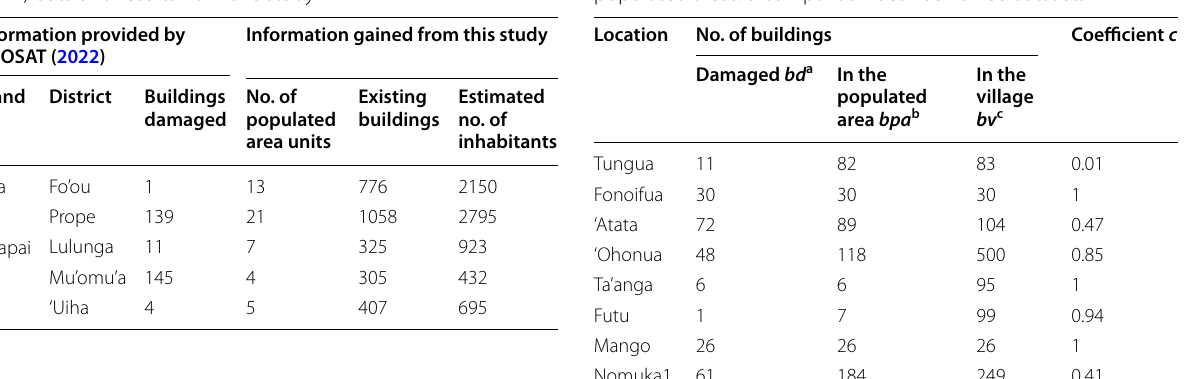
Table 6 Estimation of damages to buildings in